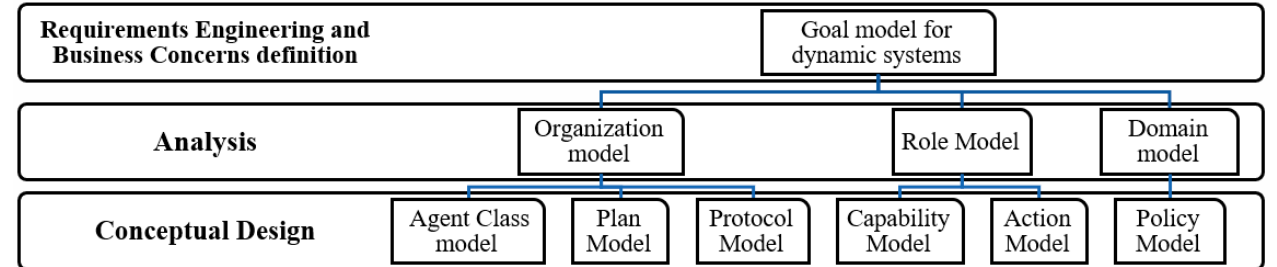
Figure 1. Architecture design approach according to O-MASE .